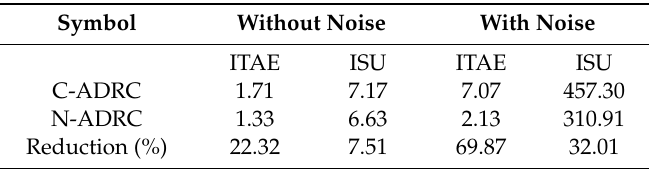
Figure 8. The derivative of the generalized disturbance. ( a )